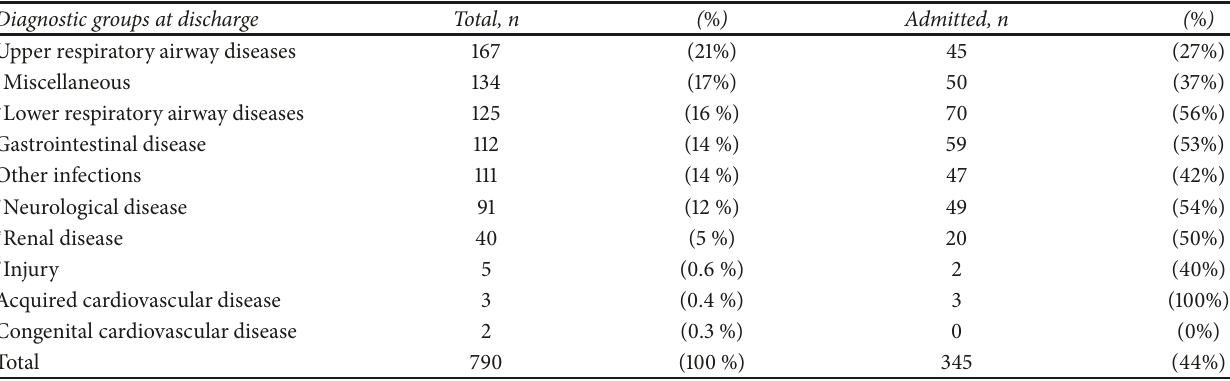
Table 1: Distribution of the diagnostic groups at discharge .